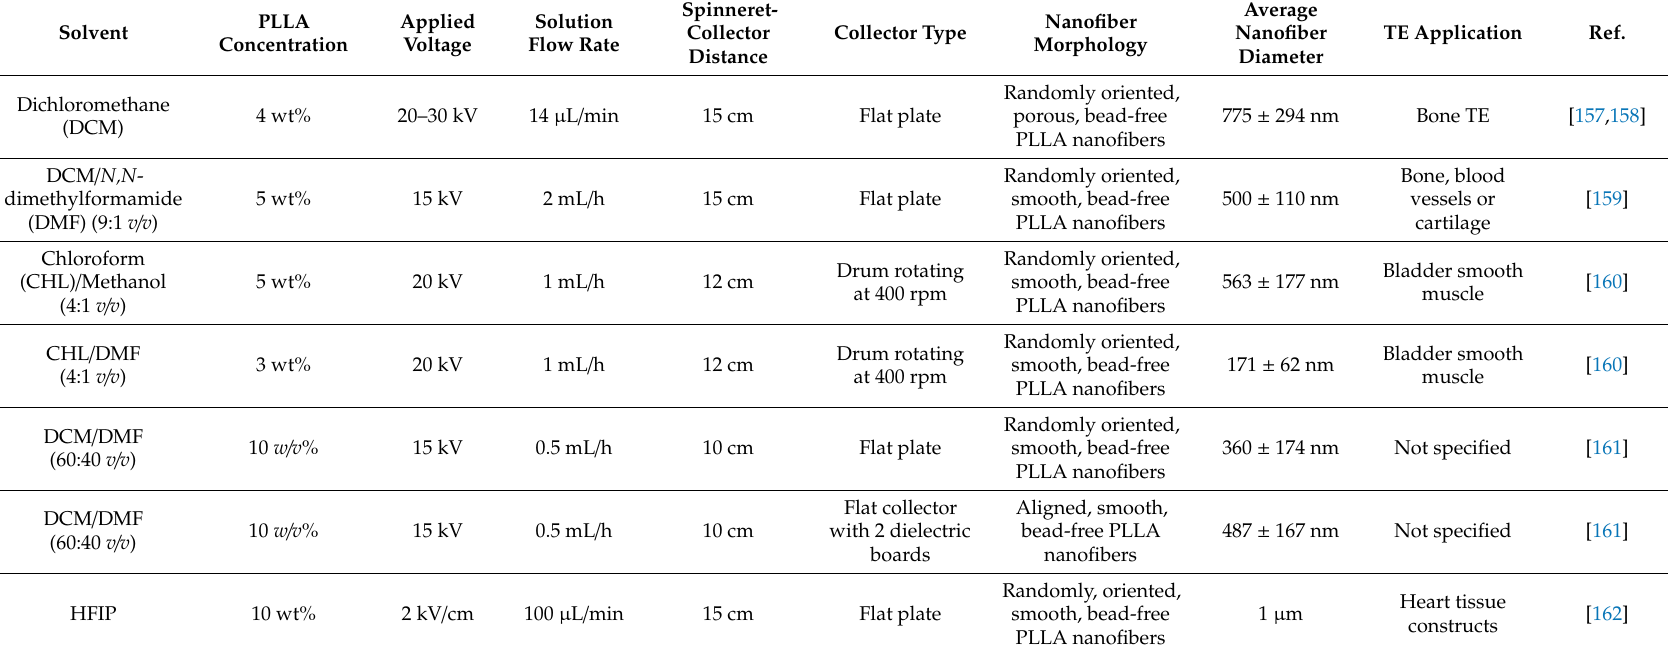
Table 2. Examples of the fabrication of electrospun PLLA sca ff olds for TE